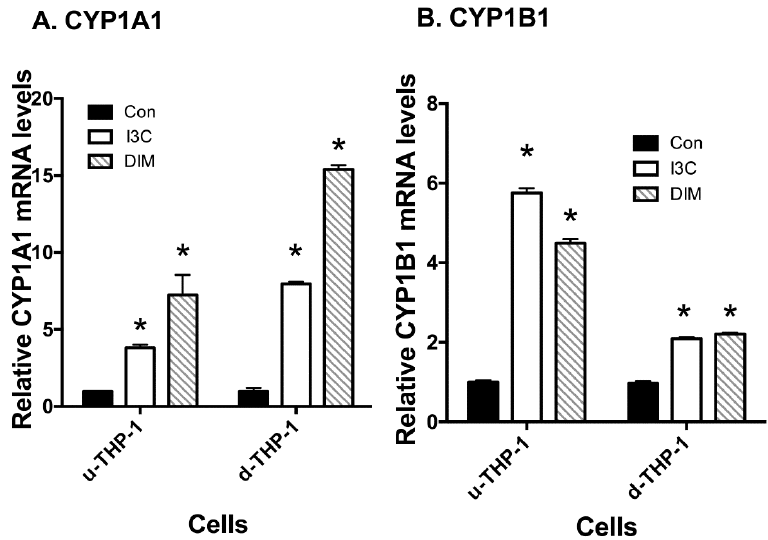
Figure 3. Effects of I3C and DIM on CYP1A1/B1 mRNA levels in THP-1 cells. THP-1 cells were differentiated using PMA as described in Materials and Methods. U-THP-1 and d-THP-1 cells were treated with or without I3C or DIM as described in Materials and Methods. After treatment with the compounds, total RNA was isolated and gene expression was determined using RT-PCR. ( A ) Effects on CYP1A1; ( B ) Effects on CYP1B1. Results are expressed as mean ± SD ( n = 3). * indicates significant difference from vehicle control at p ≤ 0.05.